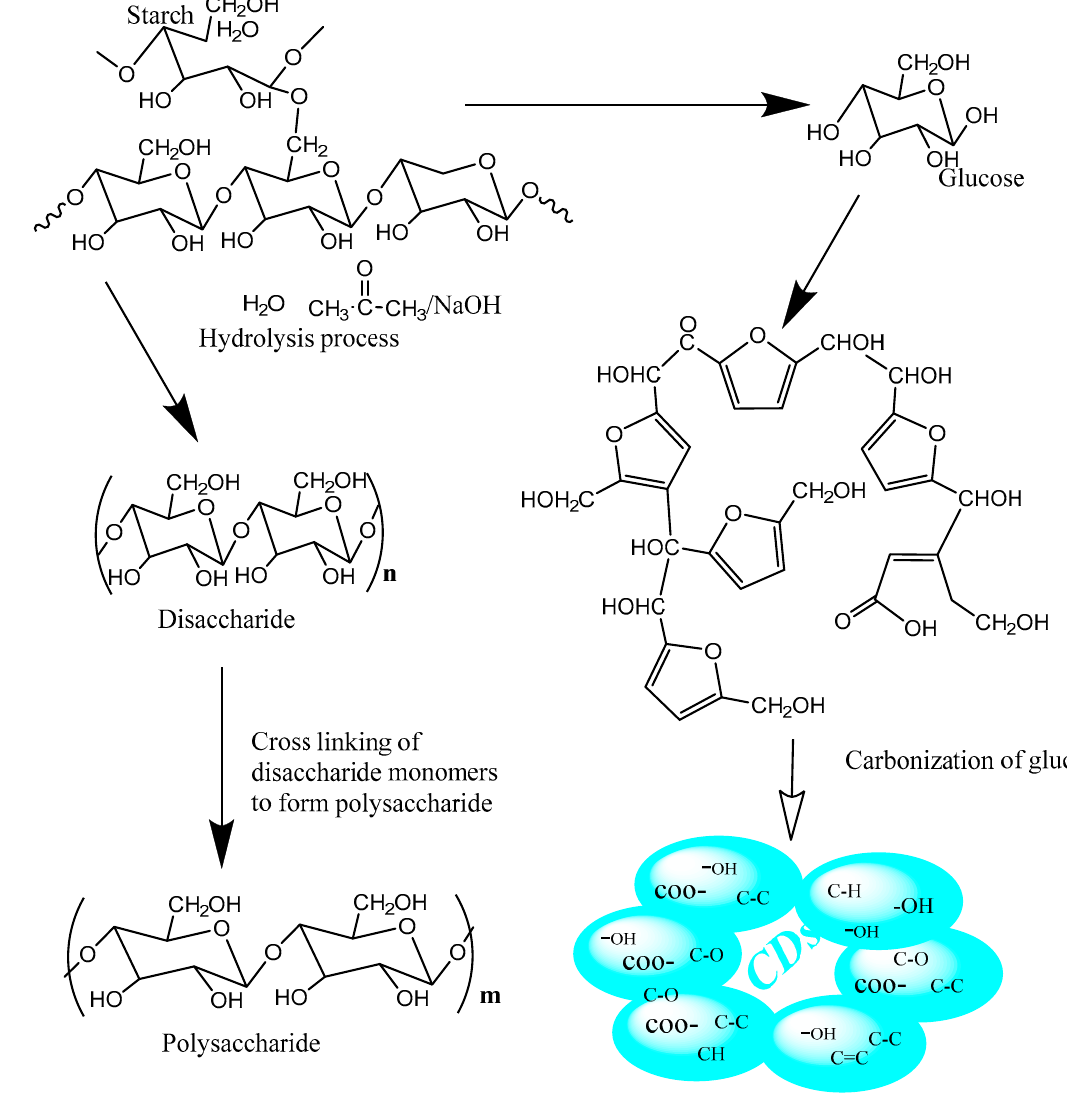
Figure 1. Carbon dots synthesis mechanism.